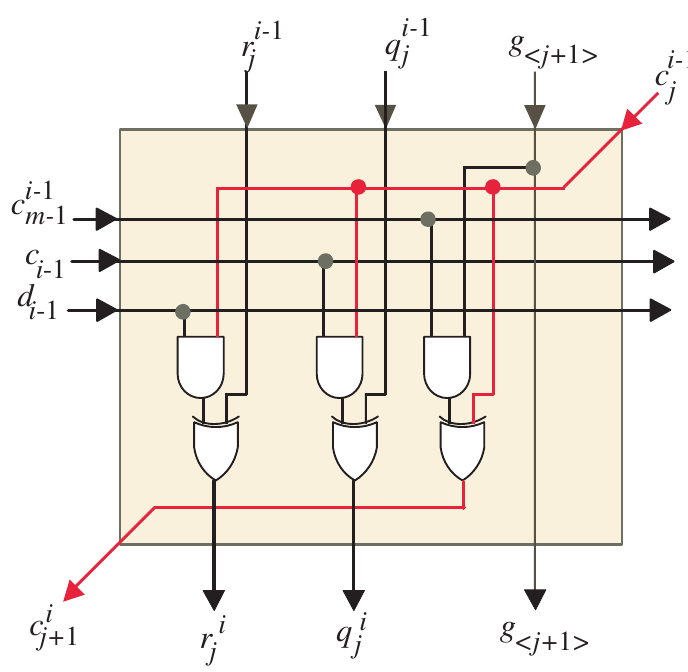
Figure 8. Light Orange PE details of SISO two-dimensional systolic